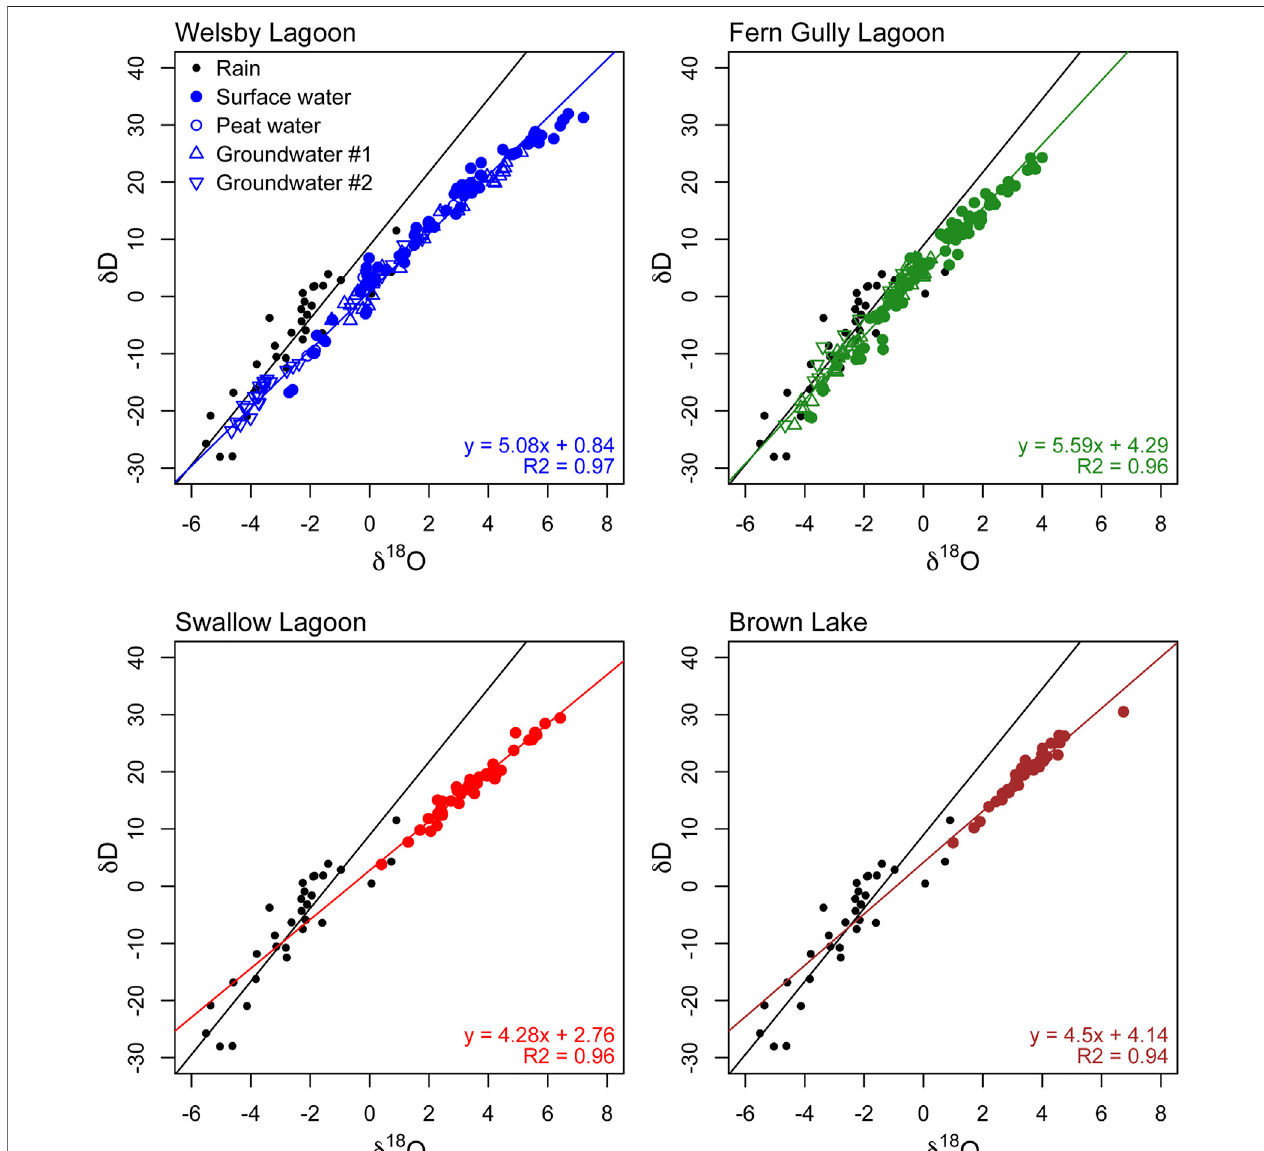
FIGURE5| Scatterplotsof δ 18 Ovs. δ 2 Hforprecipitation(blackpoints)andwetlandwaters(colouredpoints)forallsites.ForWelsbyLagoonandFernGullyLagoon, different symbols indicate different water sample types, namely peat water and the groundwater from one of two bores.